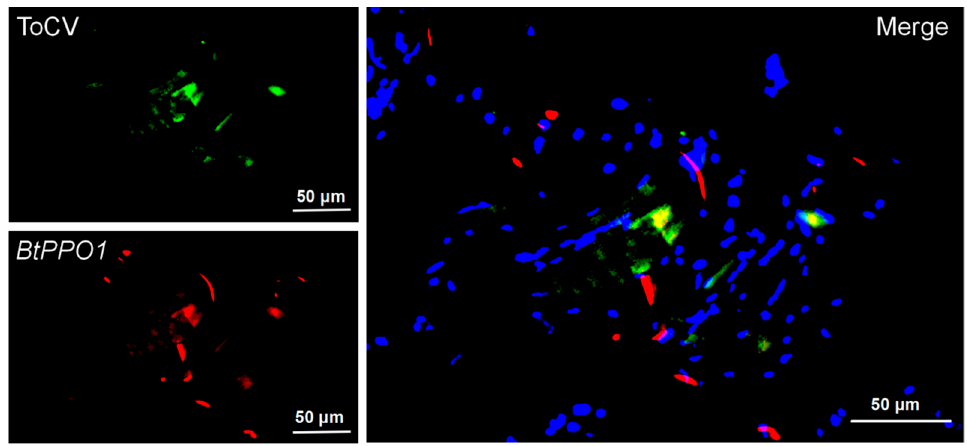
Figure 4. Fluorescence in situ hybridization analysis of symbionts BtPPO1 and ToCV in Bemisia tabaci adult thorax. ToCV glows green by excitation wavelength 465–495 nm and emission wavelength 515–555 nm, and BtPPO1 glows red by excitation wavelength 510–560 nm and emission wavelength 590 nm. The nuclear staining by DAPI was blue under ultraviolet excitation.